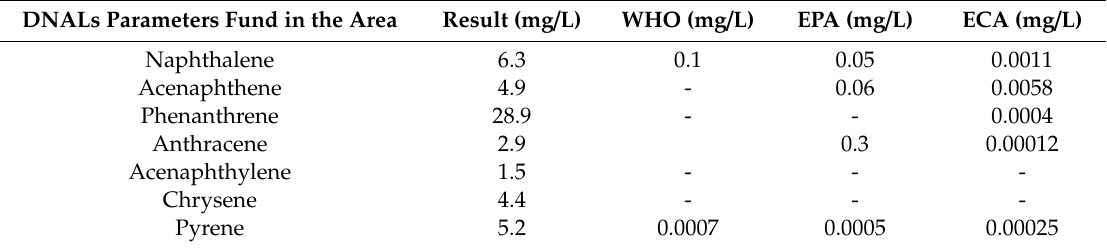
Table 11. Result of DNAPL components at Chalka P.S. and Sulaimaniyah Oil R.D. DNALs Parameters Fund in the